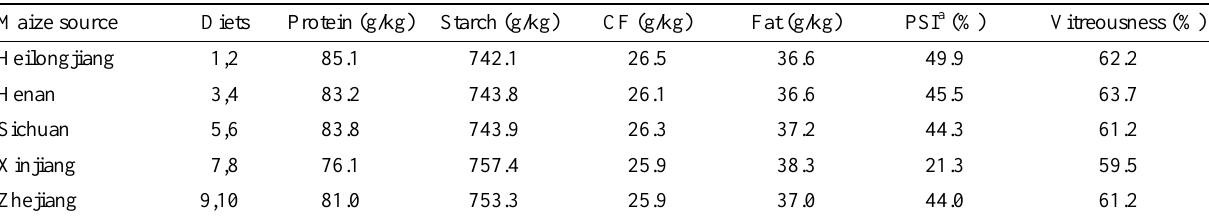
Table 4. Proximate and physio-chemical analysis of maize samples